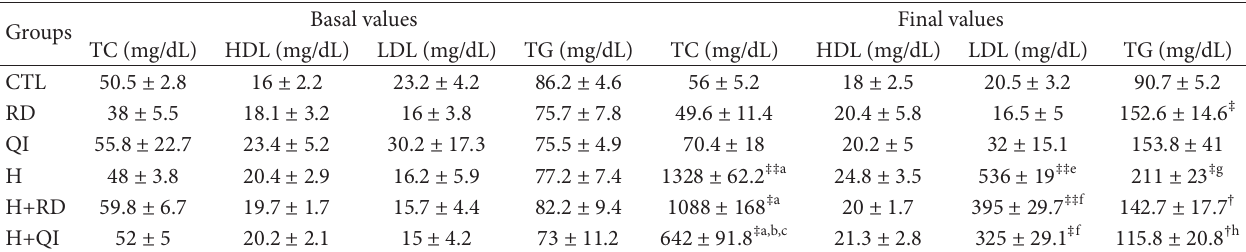
Table 1: Plasma lipids levels in different animal groups.